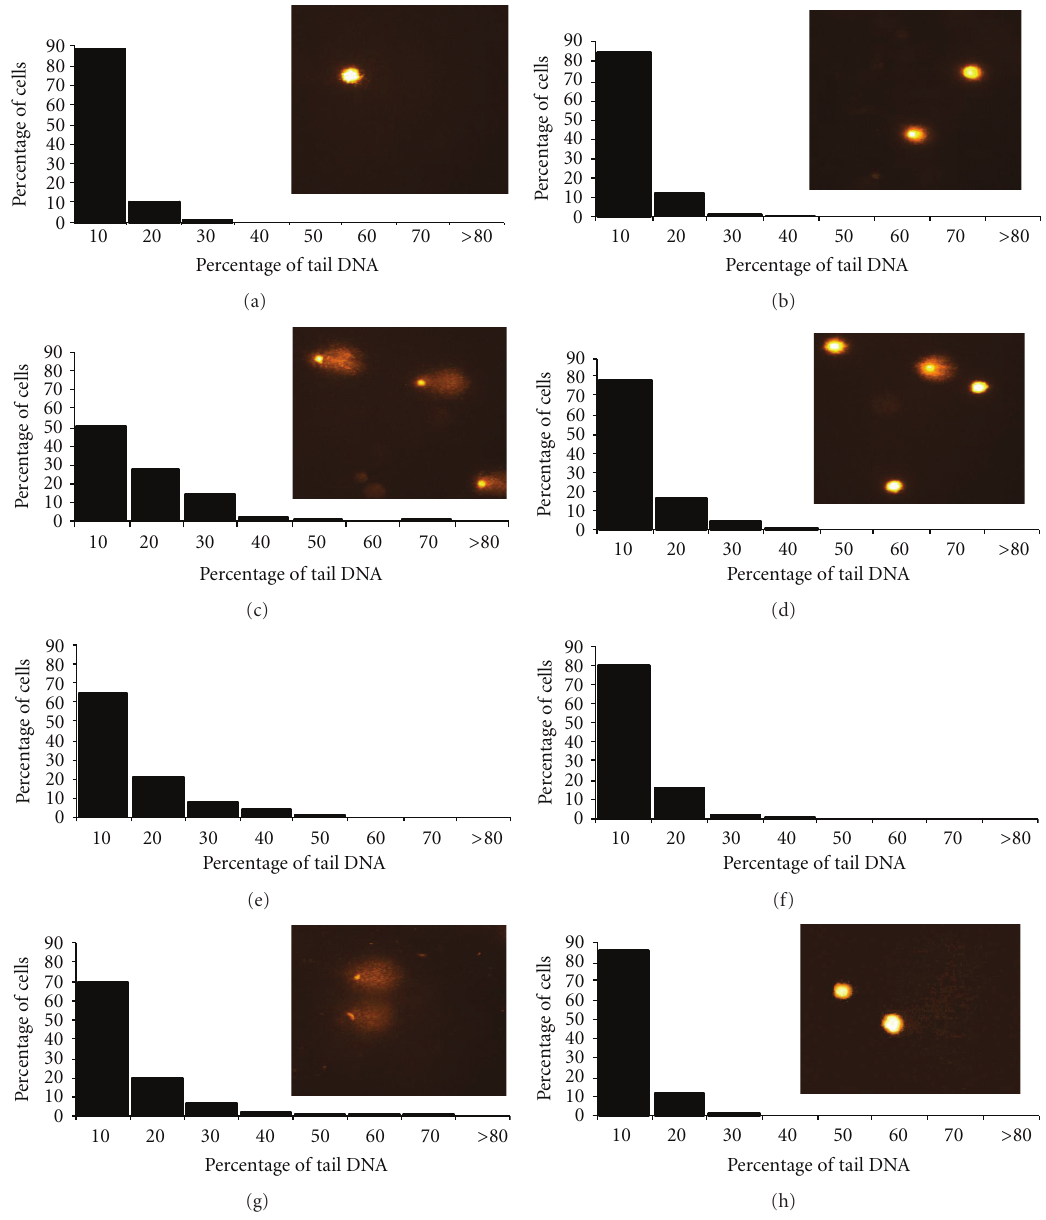
Figure 4: Histograms of the distribution of comet tail DNA obtained after a 3 day exposure of astrocytes to 20 mM ethanol, preceded or not by a 1h pretreatment with resveratrol (5 μ M) and followed or not by a 1h or 3h recovery period in fresh culture medium. (a) Control; (b) pretreatment with resveratrol; (c) 3-day exposure to ethanol; (d) pretreatment with resveratrol followed by exposure to ethanol; 1 h recovery (e) and 3h recovery (g) of astrocytes after ethanol exposure; 1-h recovery (f) and 3h recovery (h) of astrocytes after ethanol exposure when cells were first pretreated with resveratrol. (a) versus (c), (d) versus (c), (f) versus (e), P < 0 . 0001, Kolmogorov-Smirnov test. Experimental conditions are detailed in Section 2. Insets show representative micrographs of “comet,” corresponding to the various cell treatments described in the